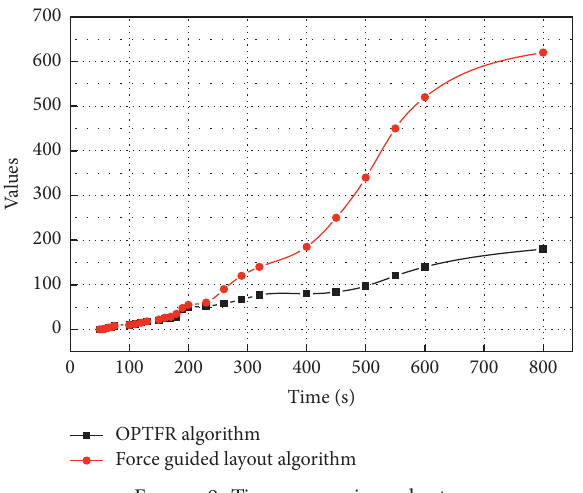
Figure 9: Time comparison